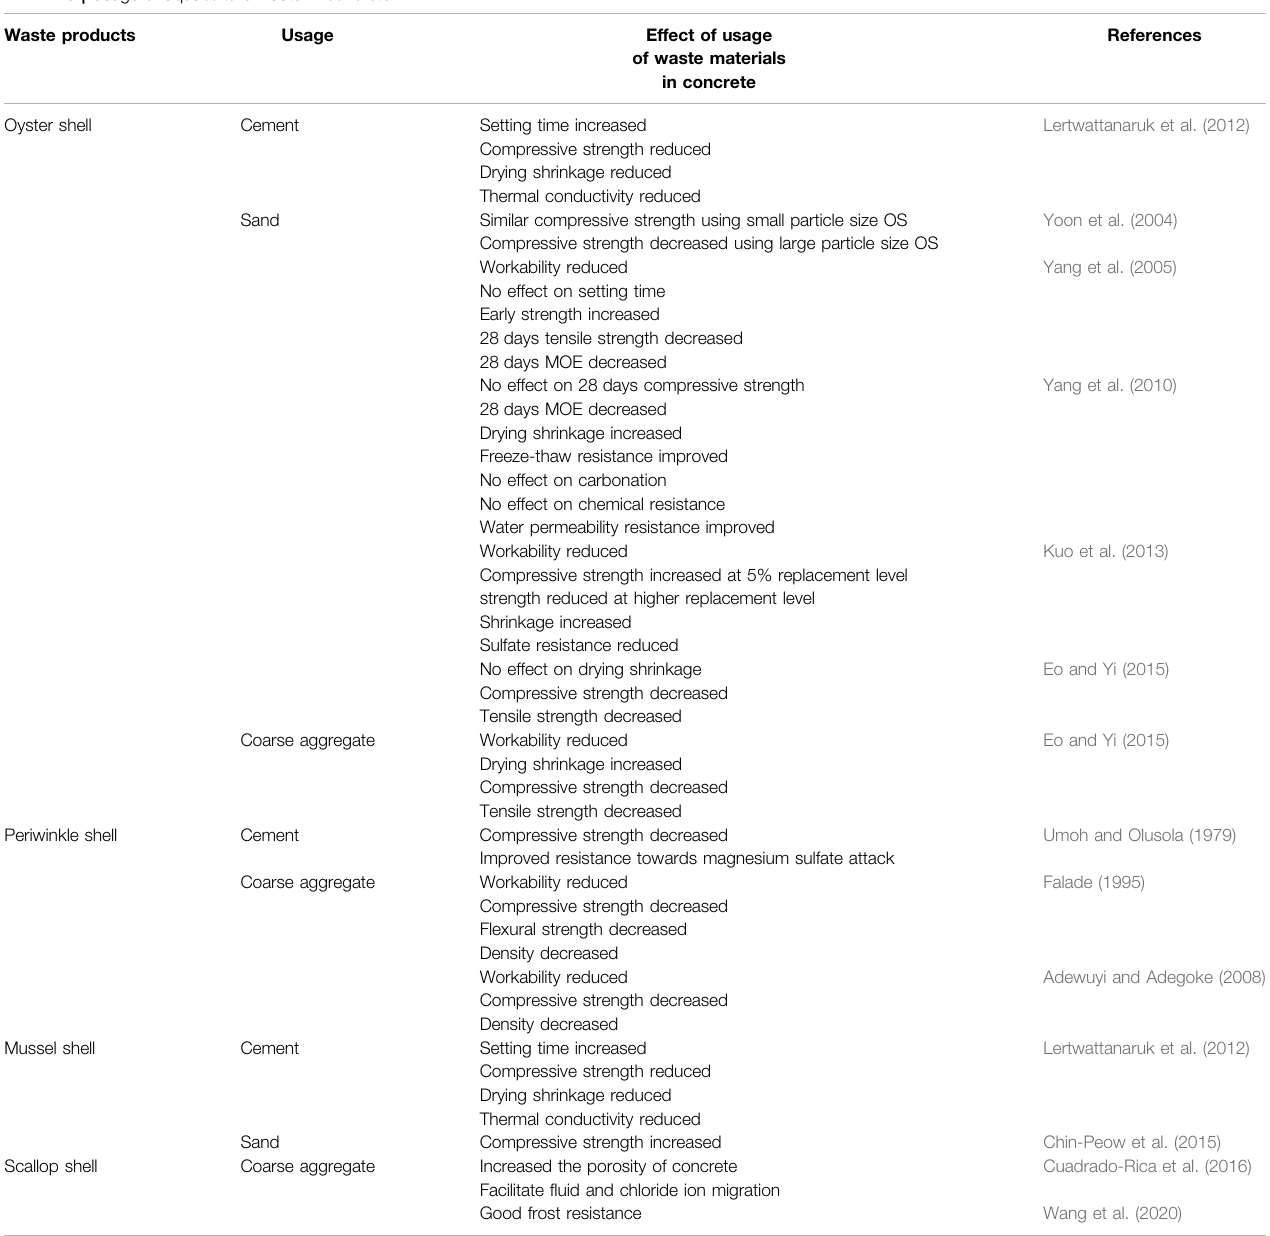
TABLE 8 | Usage of aquaculture waste in